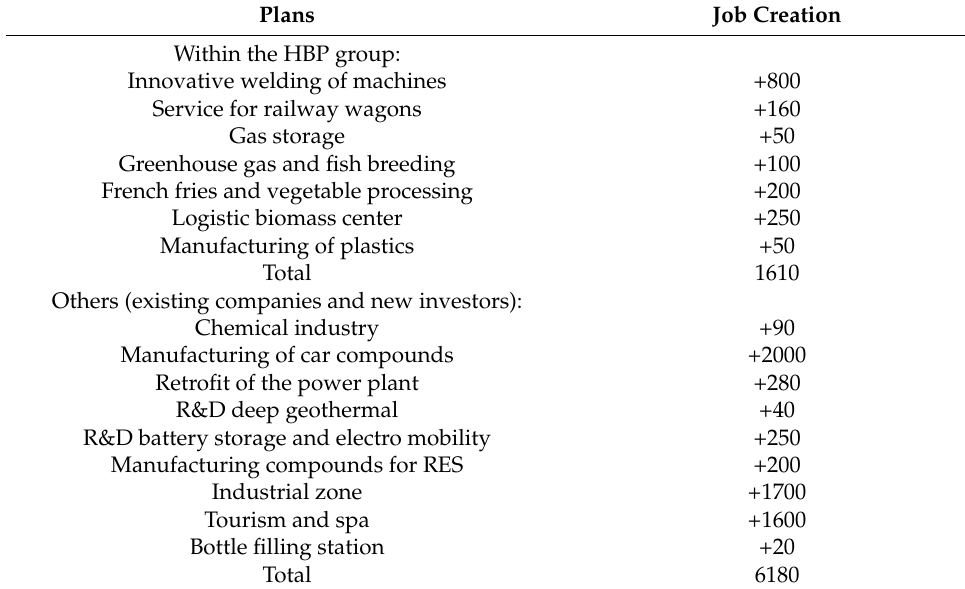
Table 4. Examples of plans for regional development and their potential for job creation.